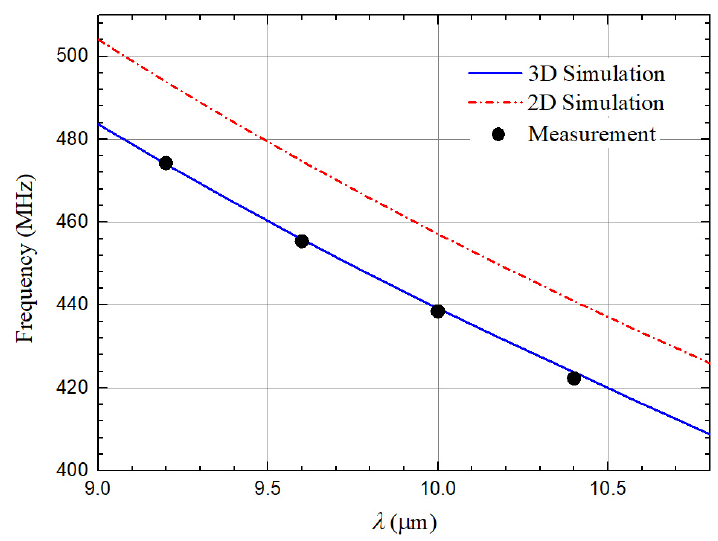
Figure 6. 2D, 3D FEA simulated and measured frequencies with different λ .